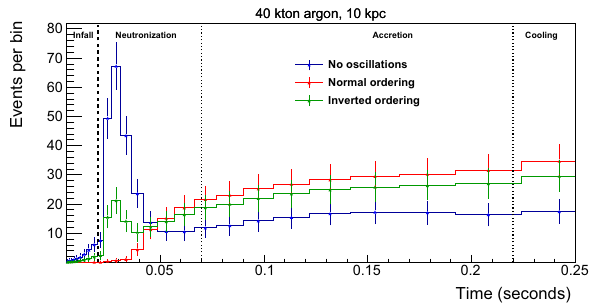
Fig. 11 Expected event rates as a function of time for the electron- capture model in [8] for 40 kton of argon during early stages of the event – the neutronization burst and early accretion phases, for which self-induced effects are unlikely to be important. Shown are: the event rate for the unrealistic case of no flavor transitions (blue) and the event rates including the effect of matter transitions for the normal (red) and inverted (green) orderings. Error bars are statistical, in unequal time bins